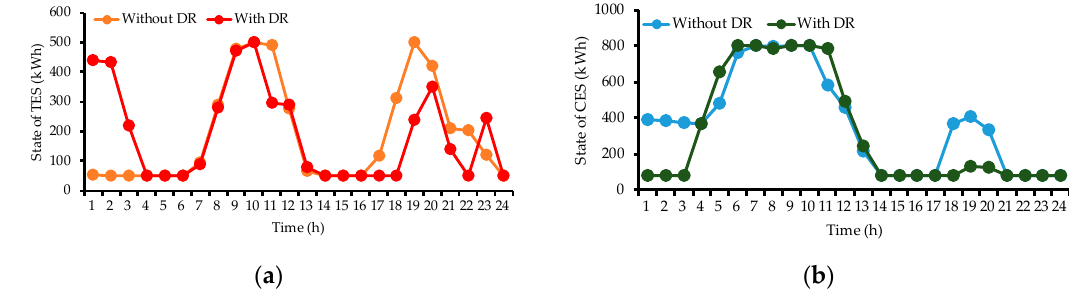
Figure 13. State variation of energy storage devices: ( a ) state of TES; ( b ) state of CES;.